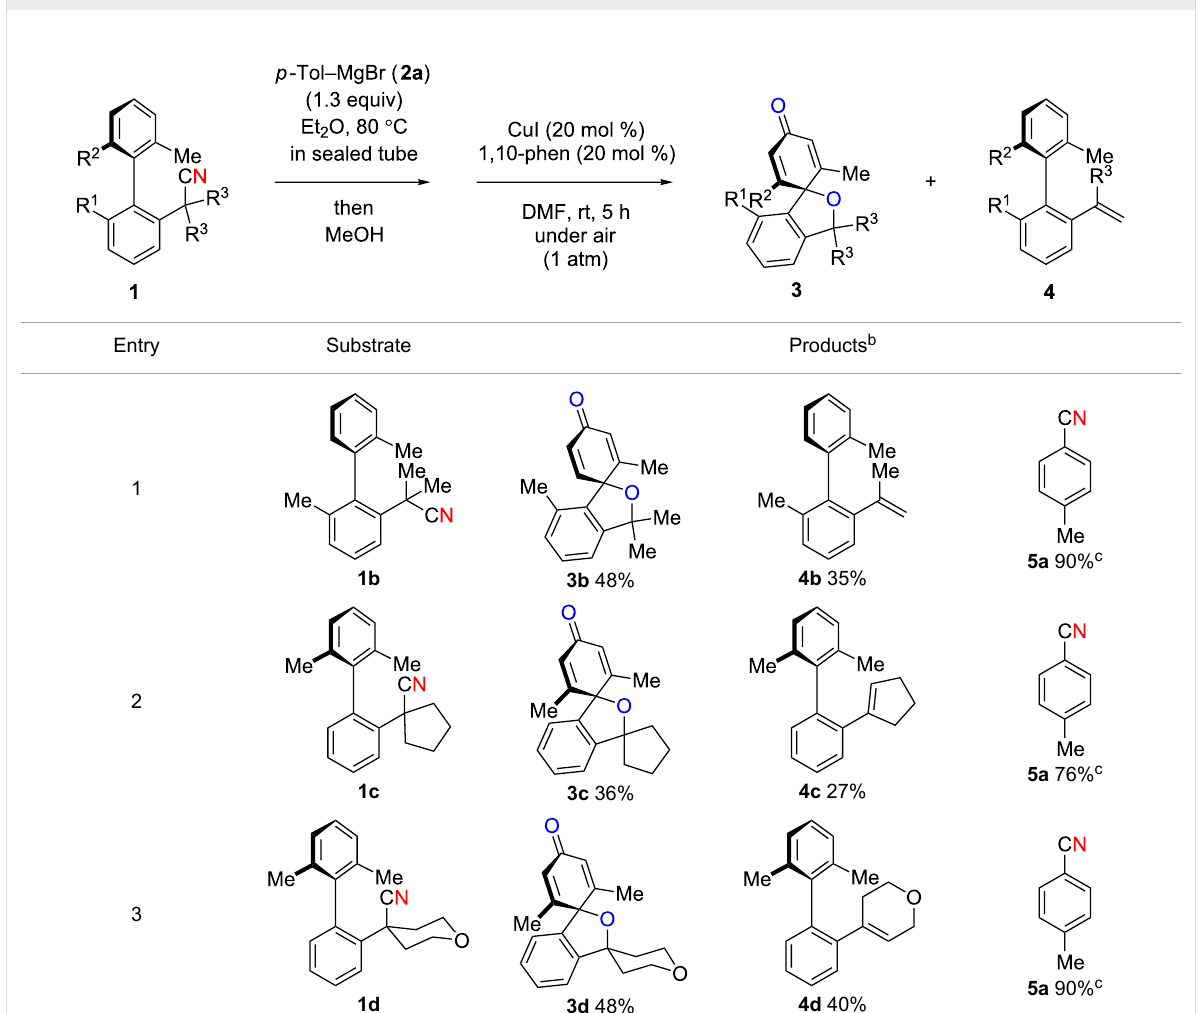
Table 2: Substrate scope: oxaspirocyclohexadienone synthesis.